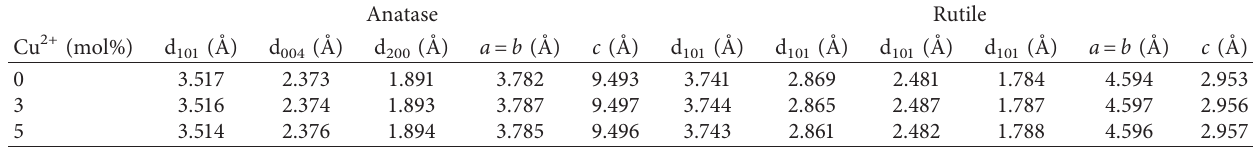
Figure 3: XRD patterns of the Cu-doped TiO 2 samples with different doping concentrations at calcination temperature (550 Table 2: The lattice parameters of the Cu-doped TiO 2 samples with different doping concentrations. Anatase